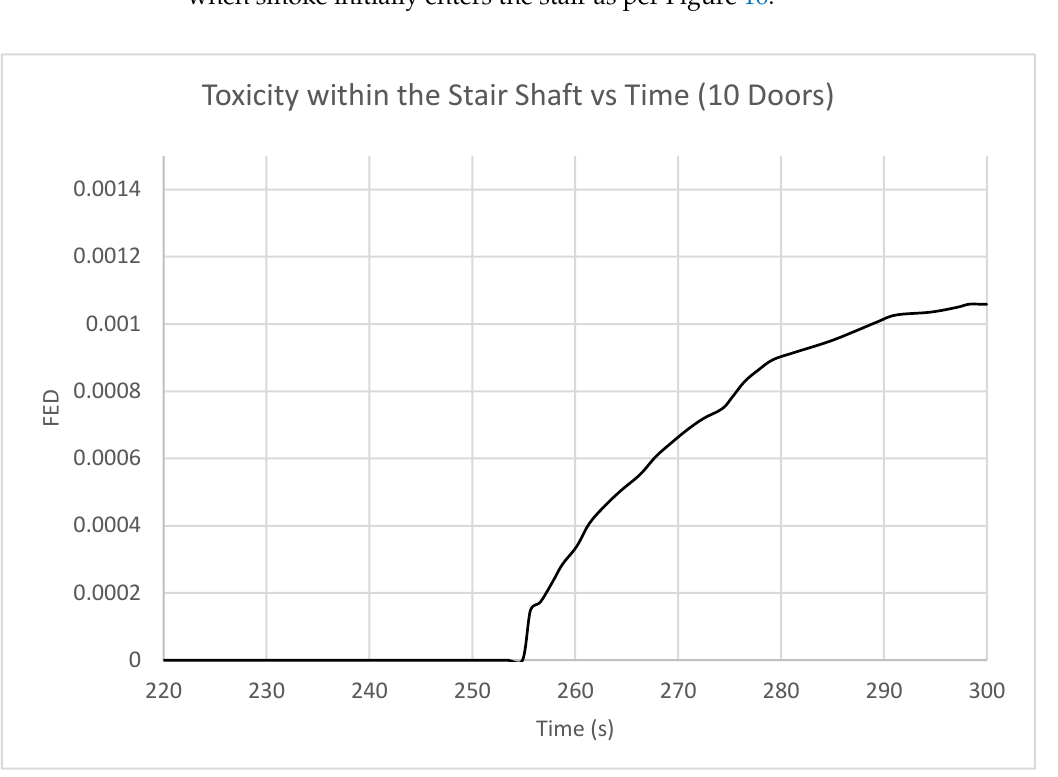
Figure 16. Toxicity within the stair shaft with 10 doors open.